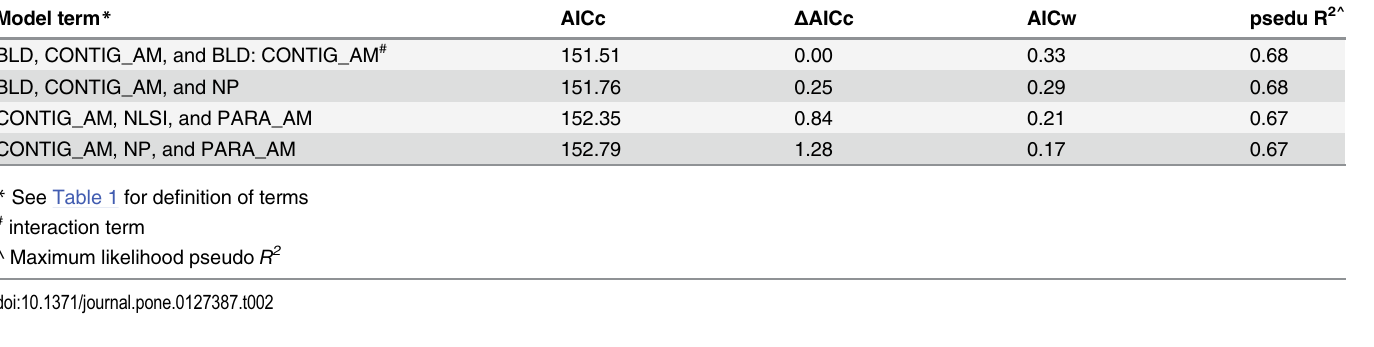
Table 2. Summary of GLMs (predictor variables restricted to three or less) supported by survey data. Model term